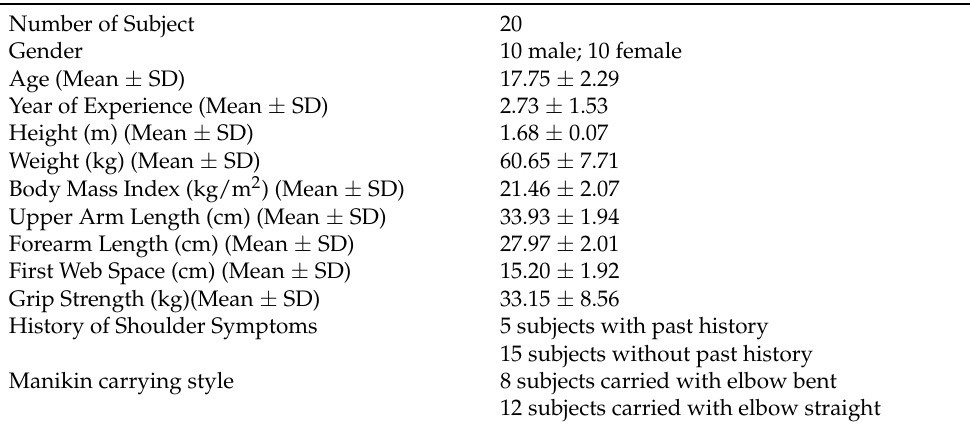
Table 4. Subject Characteristics.